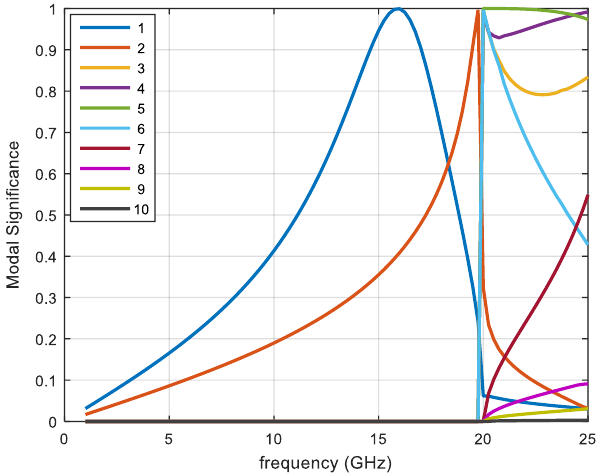
Figure 4: The modal significance values for rectangle patch inside 8 x 6 cm rectangle unit